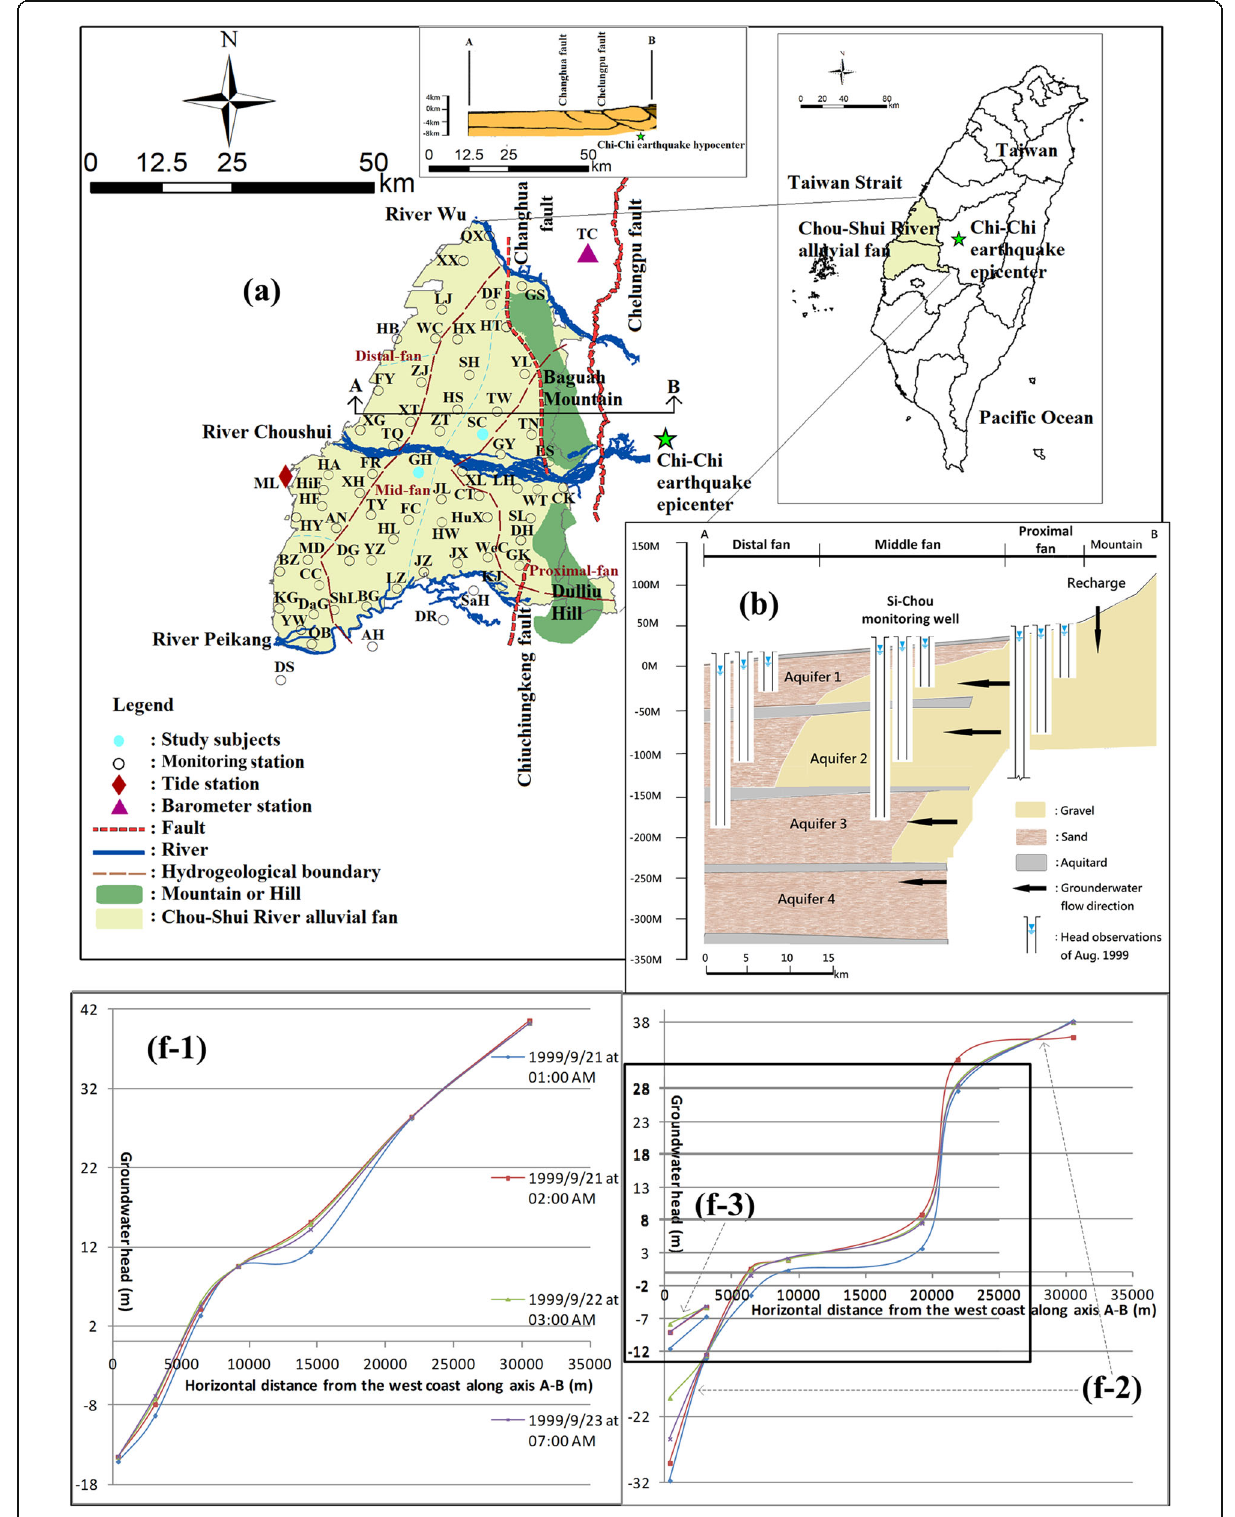
Fig. 4 (a) Study area. (b) Schematic diagram of Chou-Shui River alluvial fan groundwater strata and evolution comparison of pre-seismic and post-seismic groundwater head in aquifers 1 (f-1), 2 (f-2), and 3